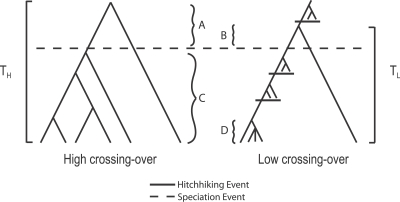
Hitchhiking Effects Can Induce a Correlation between Polymorphism and DivergenceHypothetical gene geneoligies in ancestral populations (A or B) and extant populations (C or D) for genomic regions of high crossing-over and low crossing-over (respectively) experiencing different hitchhiking effects. On average, time to the most recent common ancestor in the ancestral population is greater in regions of higher crossing-over (A) and therefore contributes more to the divergence, TH. Regions of lower crossing-over have smaller gene genealogies (D versus C) and less divergence (TL versus TH).